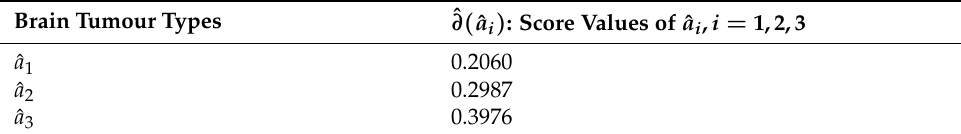
Table 13. Scores of alternatives ˆ a i , i = 1,2,3 corresponding to ˆ ℘ j , j = 1,2,3,4.